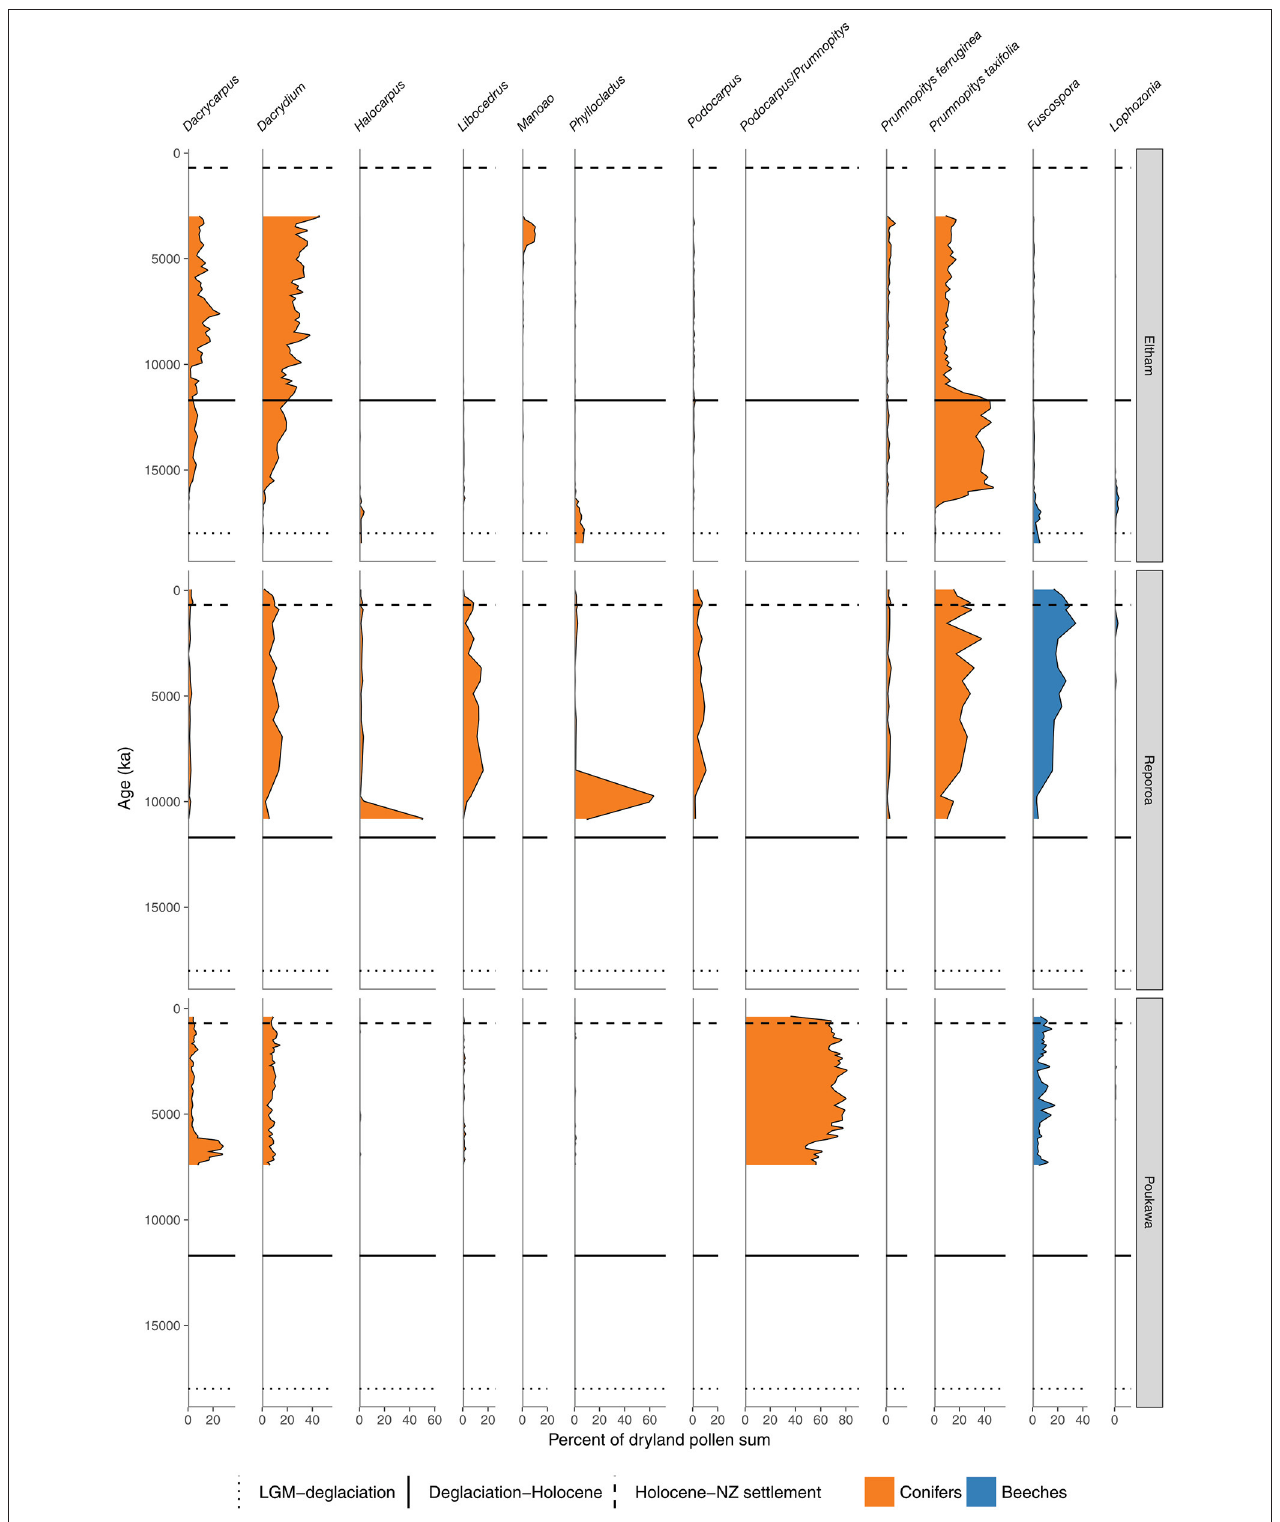
FIGURE 6 | Conifer and Nothofagaceae pollen sequences (cont.). Eltham Bog, Taranaki (McGlone and Neall, 1994). Reporoa Bog, upland central North Island (Rogers and McGlone, 1989). Lake Poukawa, Hawkes Bay (McGlone, 2002).